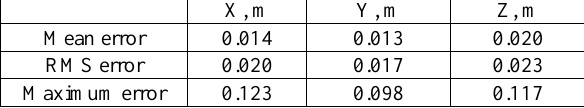
Table 7. Absolute accuracy estimation of MLS data adjustment